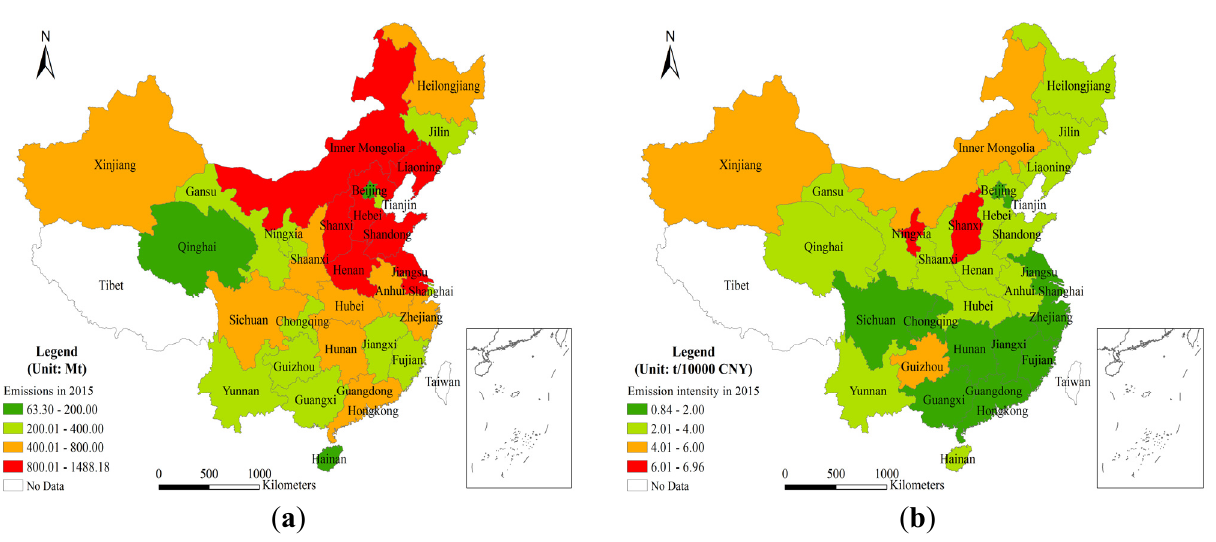
Figure 9. Provincial emissions and emission intensity distribution ( a ) CO 2 emissions in 2015; and ( b ) Emission intensity in